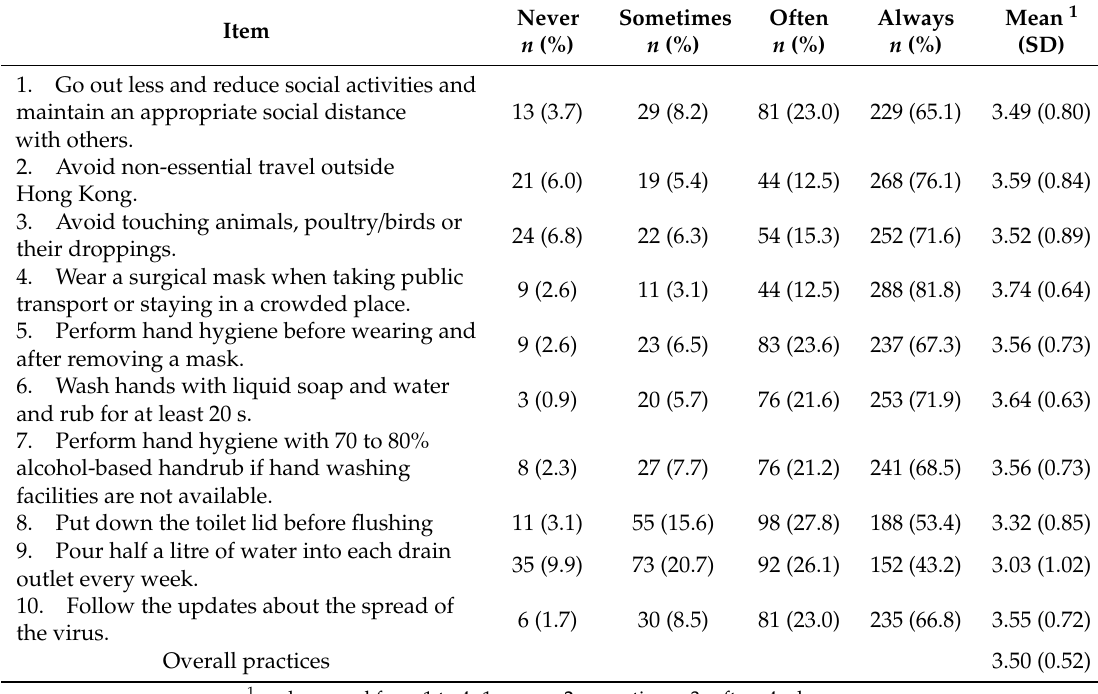
Table 4. Responses of practice of preventive measures against